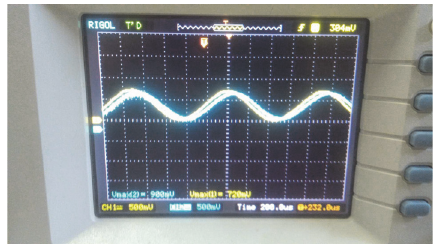
Figure 8: Experimental results of the square root function.